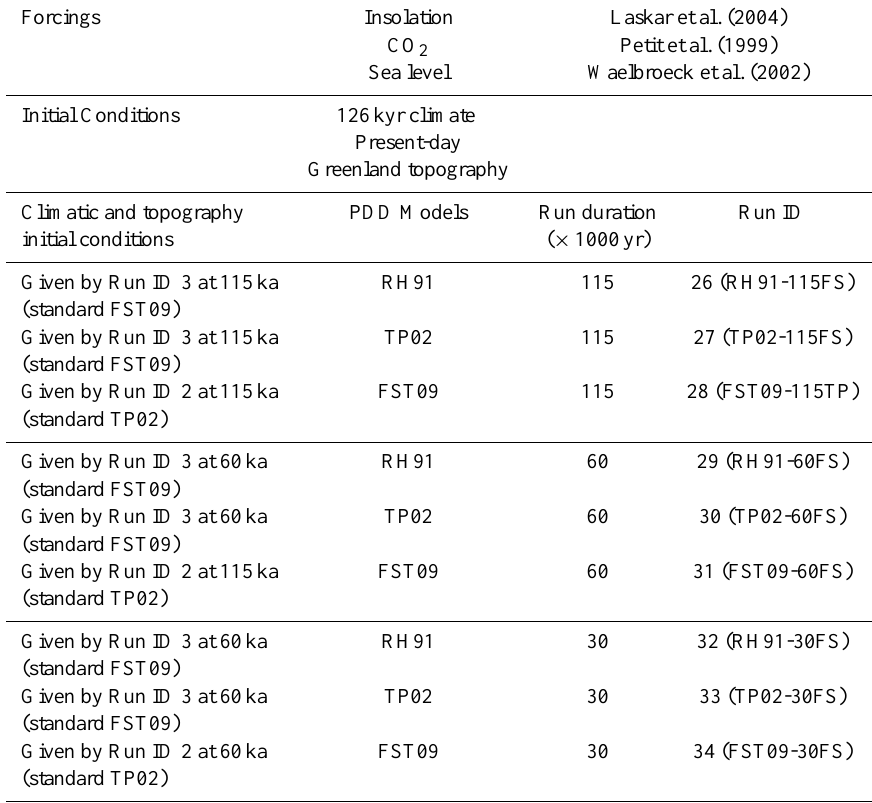
Table 4 . Sensitivity experiments to ice-sheet